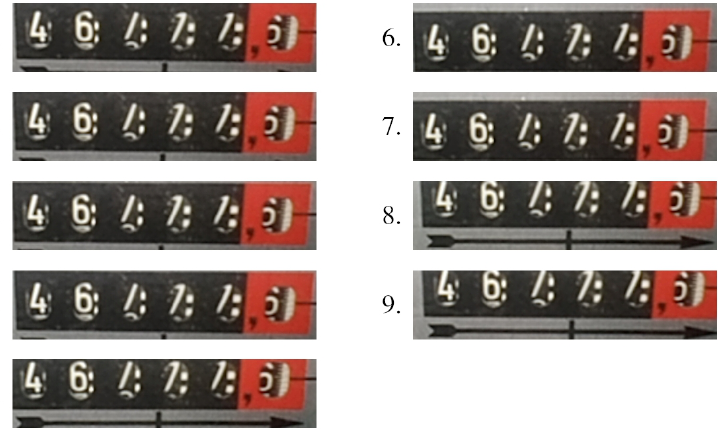
Figure 1. A set of image frame segments derived from a video stream captured by a mobile phone application. The size of fragments is 230 × 52 pixels (with 300 pixels/inch). For the purpose of presentation, images are scaled